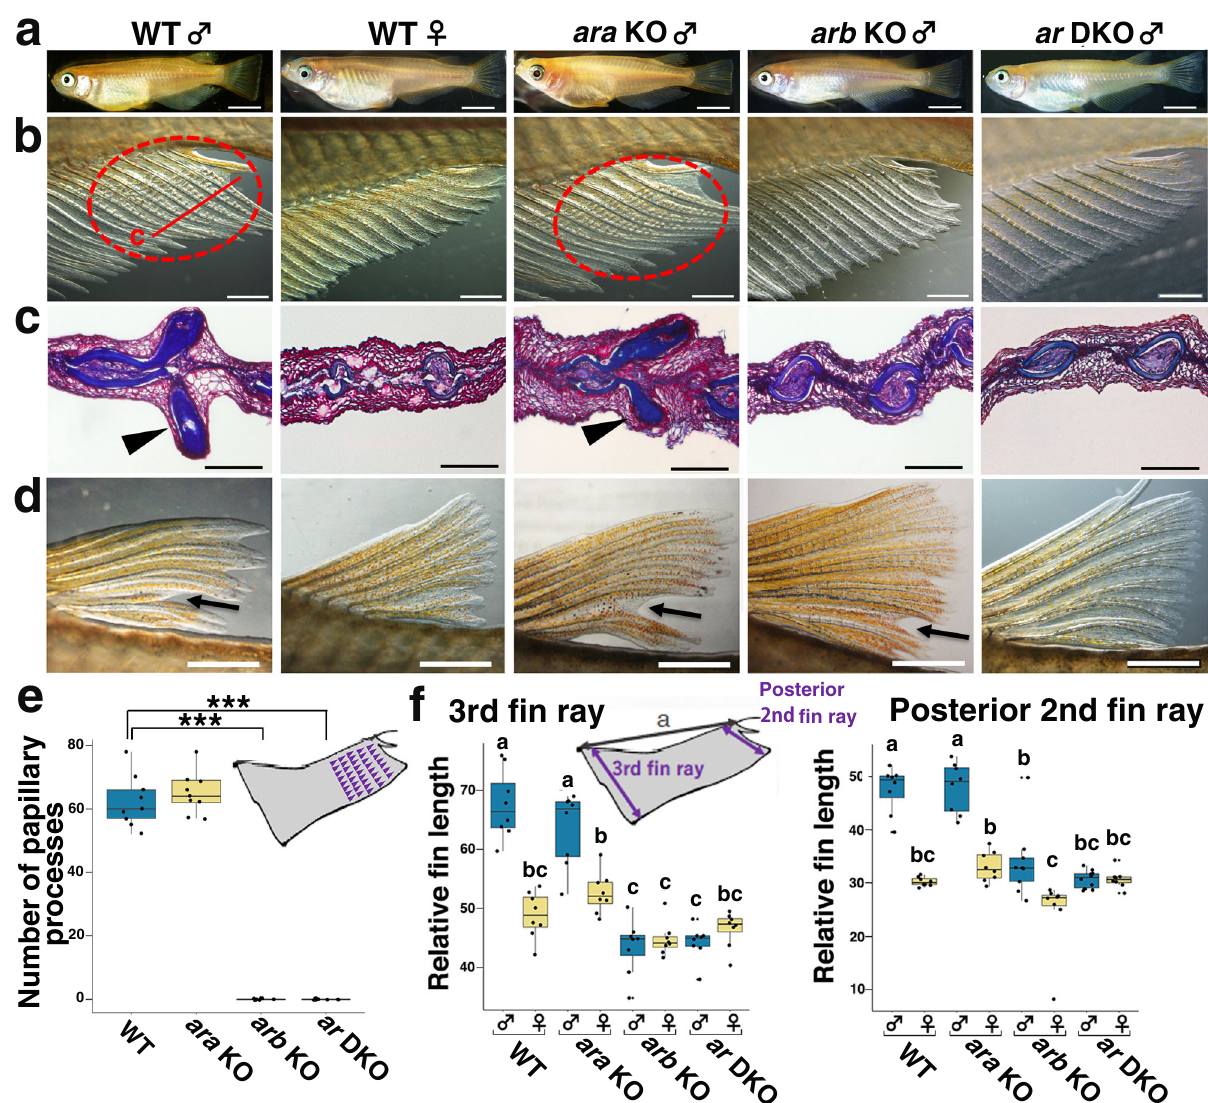
Fig. 2 | arb KO males and ar DKO males display demasculinised fi n structure, whereas ara KO males exhibit normal sexual characteristics in fi n morpho- genesis.a RepresentativepictureofthewholebodyofWTmale,WTfemale, ara KO male, arb KO male, and ar DKO males ( n ≥ 6 of each genotype). Higher magni fi ca- tion of the anal fi n ( b ), the micrographs of Masson/trichrome-stained sections of anal fi n ( c ), higher magni fi cation ofthe dorsal fi n ( d ) of WT males, WT females, ara KO males, arb KO males, and ar DKO males, respectively ( n ≥ 6 of each genotype). The papillary processes developments were marked by red dotted circles in b and arrowheads in c . The plane of tissue section of anal fi n isindicated by red line in b . Arrows in d indicate forks in the dorsal fi n. e Number of developing papillary processesinadultWT, ara KO, arb KO,and ar DKOmales( n =9foreachgenotype). The blue and light brown colours indicate WT and ara KO, respectively. The one- way ANOVA followed by two-sided Dunnett ’ s multiple comparison test